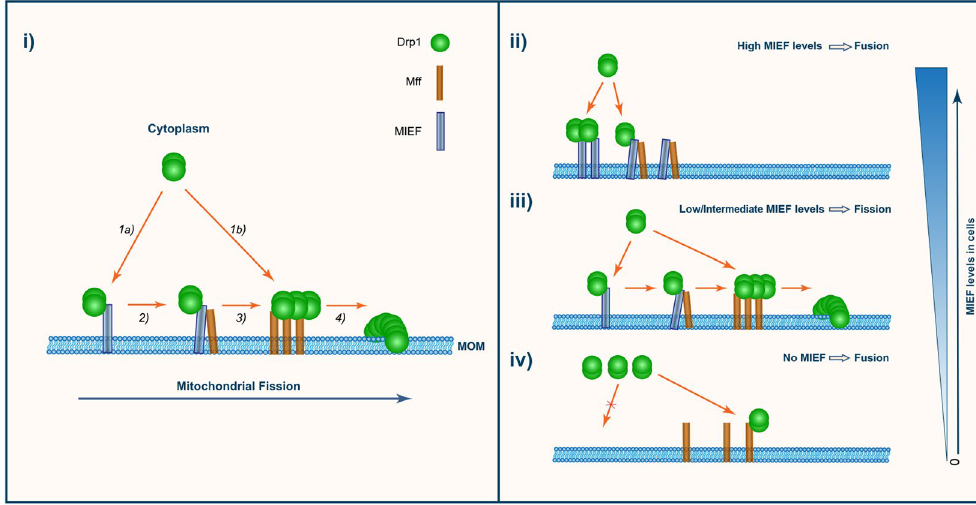
Figure 8. MIEF and Mff coordinately work in Drp1-mediated mitochondrial fission. ( i) A working model illustrating how Drp1-mediated mitochondrial fission is regulated by a sequential and coordinated interaction of MIEF and Mff with Drp1. (1) At the initial step of fission, Drp1 is recruited by MIEF (1a) and also by Mff (1b) from the cytosol to the mitochondrial surface. (2) At the mitochondrial surface, MIEF serves as an adaptor linking Drp1 and Mff together in a trimeric Drp1-MIEF-Mff complex. (3) MIEF promotes a direct binding of Drp1 to Mff possibly via reassembly of Drp1 from the trimeric complex to a functional dimeric Drp1-Mff complex. (4) Drp1-mediated fission is activated, resulting in mitochondrial division. MOM: mitochondrial outer membrane. ( ii – iv ) The model depicts the outcome of different cellular levels of MIEF: ( ii) High MIEF levels inhibit fission, leading to a fusion phenotype by sequestering Drp1 in a dimeric Drp1-MIEF or trimeric Drp1-MIEF-Mff complex. ( iii ) Low/intermediate MIEF levels promote fission by facilitating a direct binding of Drp1 to Mff. ( iv ) In the absence of MIEFs, Drp1 is not effectively recruited to the MOM via MIEFs with the result that Mff itself cannot capture sufficient amount of Drp1. As a consequence, the balance of mitochondrial dynamics is shifted towards fusion, resulting in a moderate mitochondrial elongation